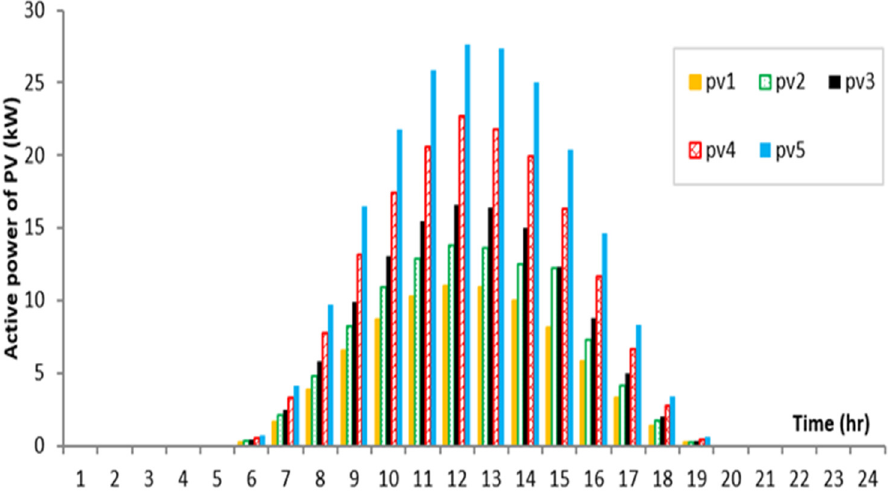
Figure 7. Scheduled output power from each PV at each hour for the first